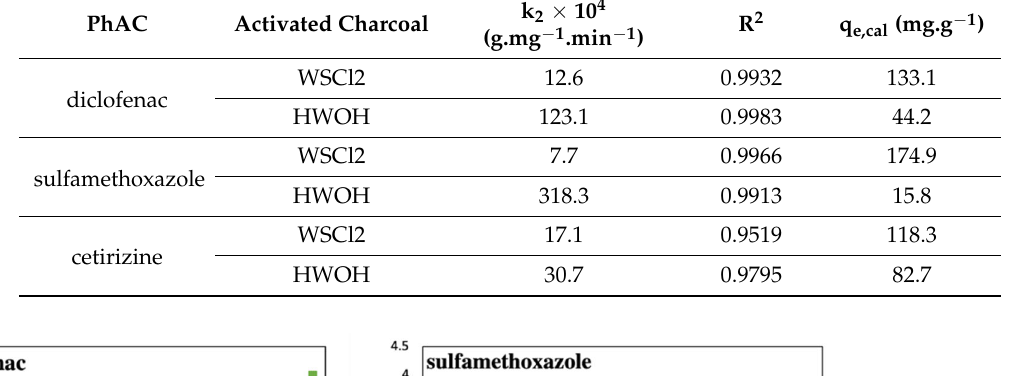
Table 5. Kinetic data of adsorption of diclofenac, sulfamethoxazole, and cetirizine on two activated charcoals fitted to the pseudo-second order.